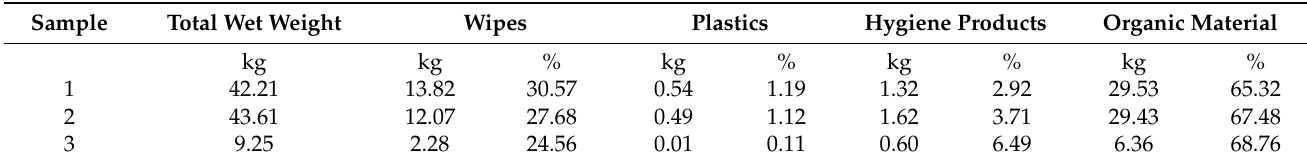
Table 2. Composition of gross solids samples from pretreatment at Villap é rez WWTP.